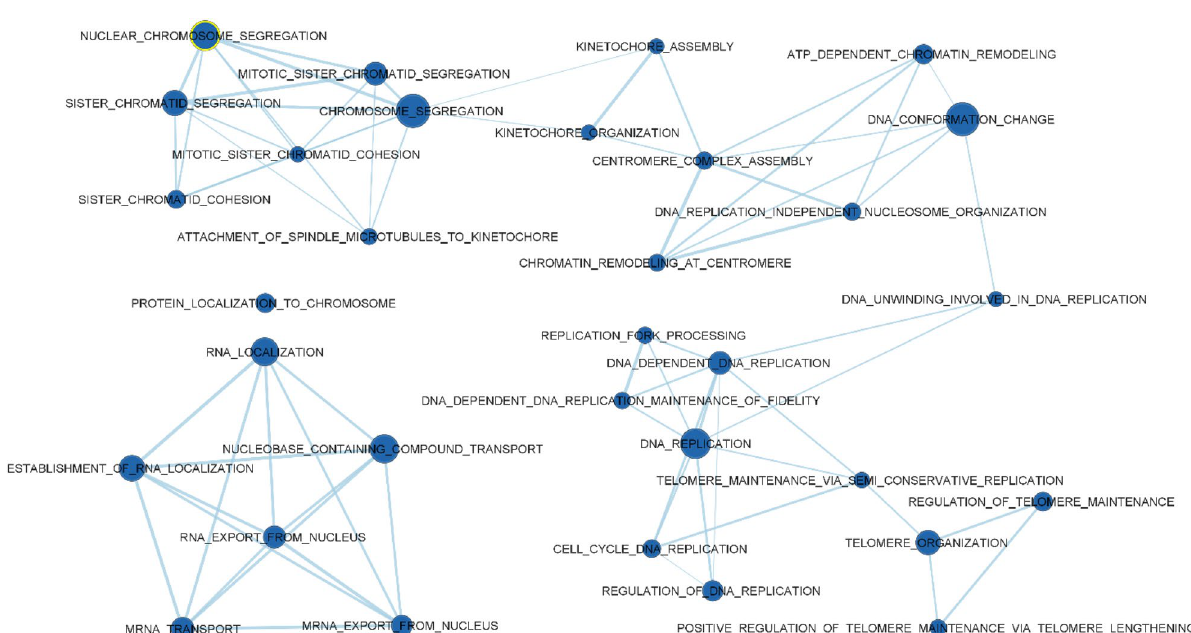
Figure 5. Gene sets upregulated in the peripheral blood of pigs sampled at 12 days post-weaning as compared to those on the day of weaning. The sets are enriched with FDR < 0.01. The edges represent the link of two or more gene sets sharing the same core group of genes, explaining the enrichment of each of the gene sets. Node colour intensity conveys enrichment significance (P-value) while their dimension increases with the number of their